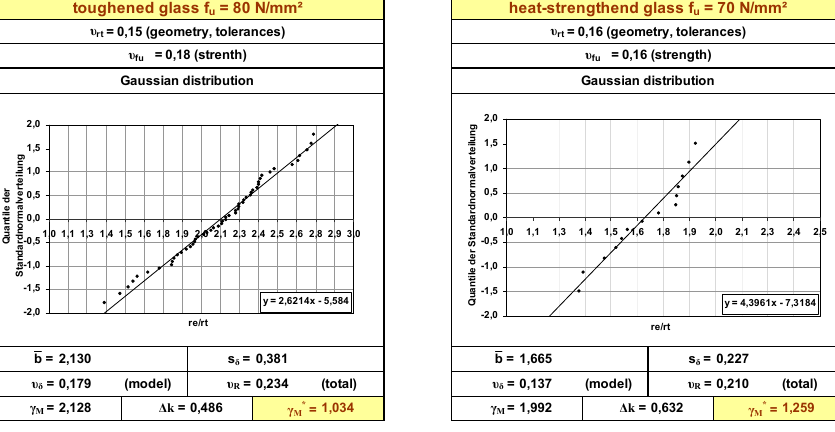
Figure 11: Derivation of the partial safety factor γ M for toughened glass and heat strengthened glass according to DIN EN 1990 Annex D with 75% confidence